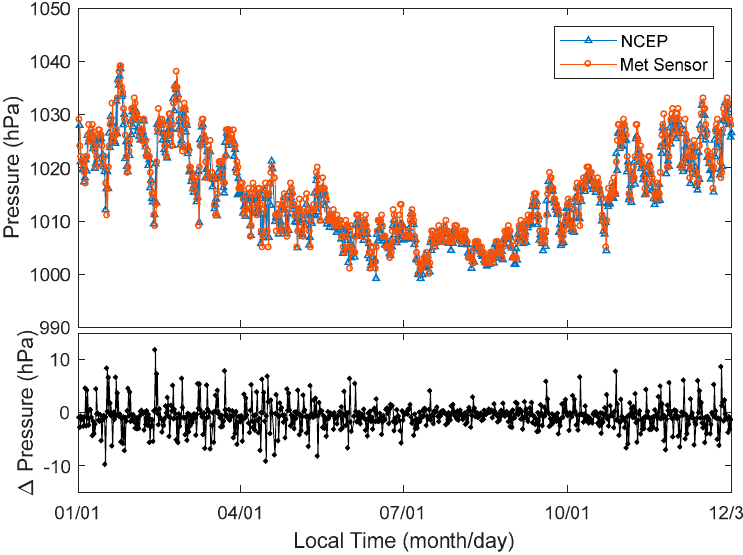
Figure 5. Pressure near GPS antenna measured twice a day and interpolated from NCEP CFSv2 ( top panel); and difference of pressure from two approaches ( bottom panel) in the whole year of 2016.